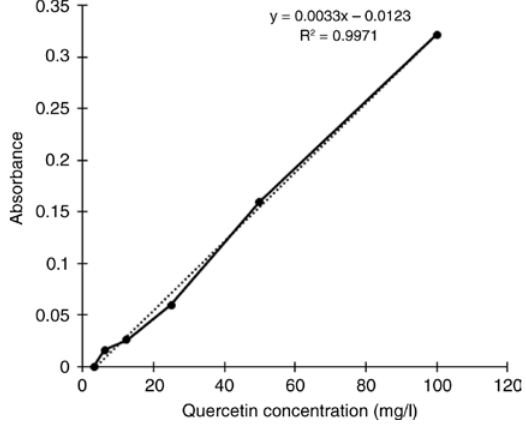
Figure 3: Quercetin calibration curve for flavonoid quantification.